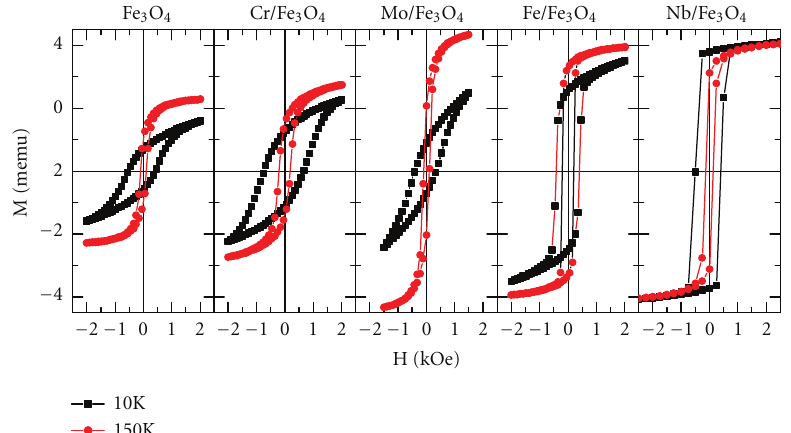
Figure 5: Hysteresis loops for Fe 3 O 4 grown simultaneously on MgO (100) substrates with and without 30 ˚A transition metal bu ff er layers. The SQUID magnetometry measurements were performed with a measurement field of 100 Oe applied along the (100) direction of the